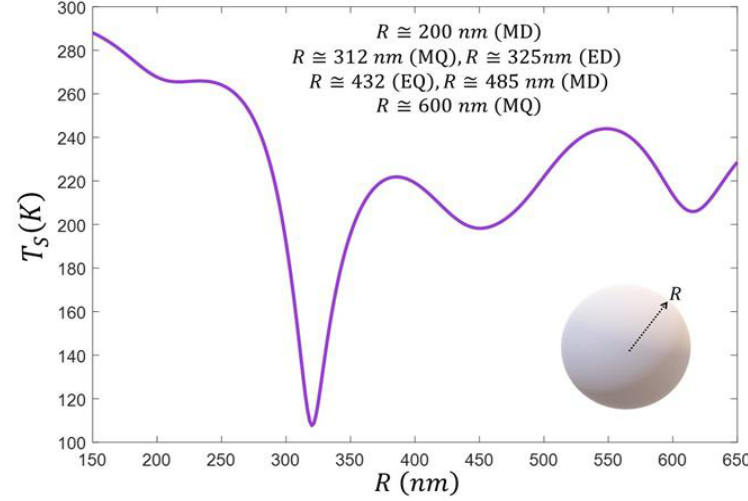
Figure 5. Sample temperature, 𝑇 𝑆 , versus the radius of the sample. Resonant radii of the nanospheres supporting MD, ED, MQ, and EQ modes are presented for simplicity of understanding [29].